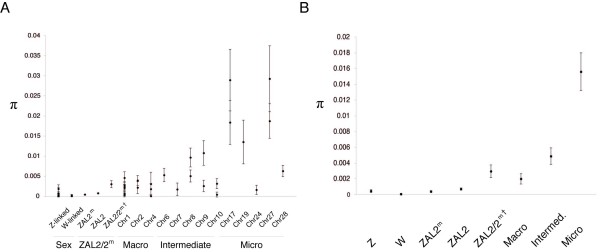
Average diversity across the sparrow genome. ZAL2 and ZAL2m refer to average π within the inversion interval on each chromosome arrangement and ZAL2/2m† indicates the region outside the inversion on white-throated sparrow chromosome 2. They are shown for reference. A. Average genetic diversity (π) per locus. B. Average genetic diversity (π) for each chromosome type is calculated from concatenated sequences from all loci within that chromosome type. Error bars represent 95% CI (± 1.96 × SD). Note that the chromosomes labeled as Chr refer to the predicted orthologous chromosome in chicken.